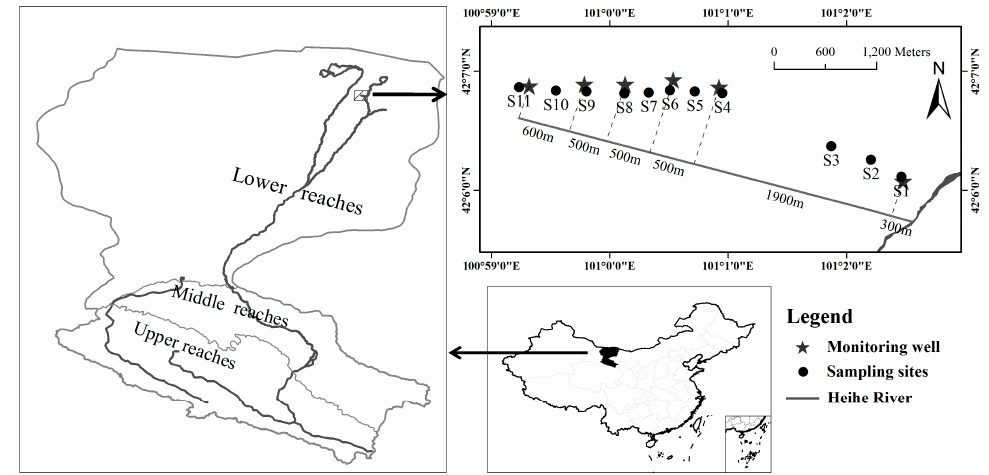
Figure 1. The Heihe River basin in northwestern China and the locations of the sampling sites.